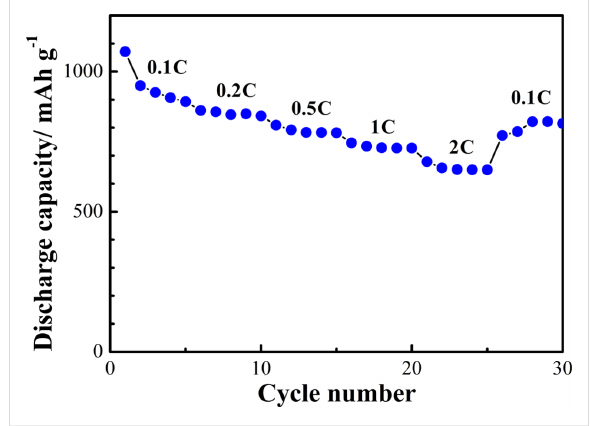
Figure 10: Rate capability of the S/ZnO@NCNT composite cathode.